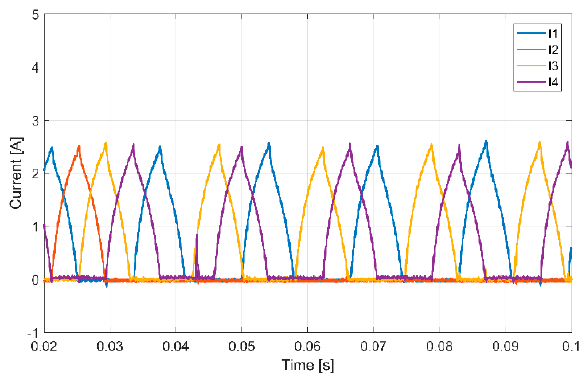
Figure 19. Diagnostic variables associated with the motor winding currents of the SRM at 600 rpm in normal operation and open-circuit failure of power device S 1 A (experimental result).